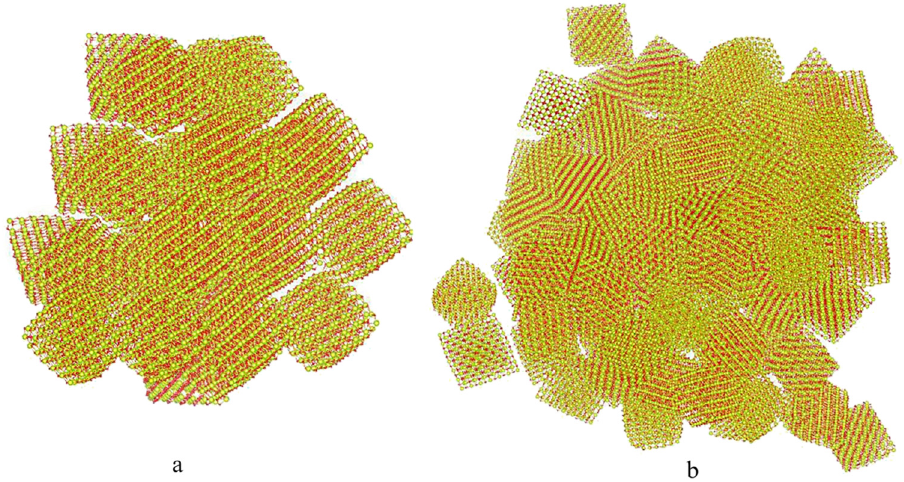
Figure 3: Structure of agglomerated octahedral and spherical nanoparticles: ( a ) 10 nm in size and ( b ) 20.6 nm